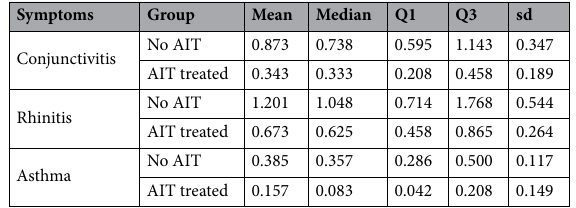
Table 3. Descriptive statistics: mean, median, 25% quantile (Q1), 75% quantile (Q3), and standard deviation (sd), related to the average number of daily symptoms per person for each category of symptoms.